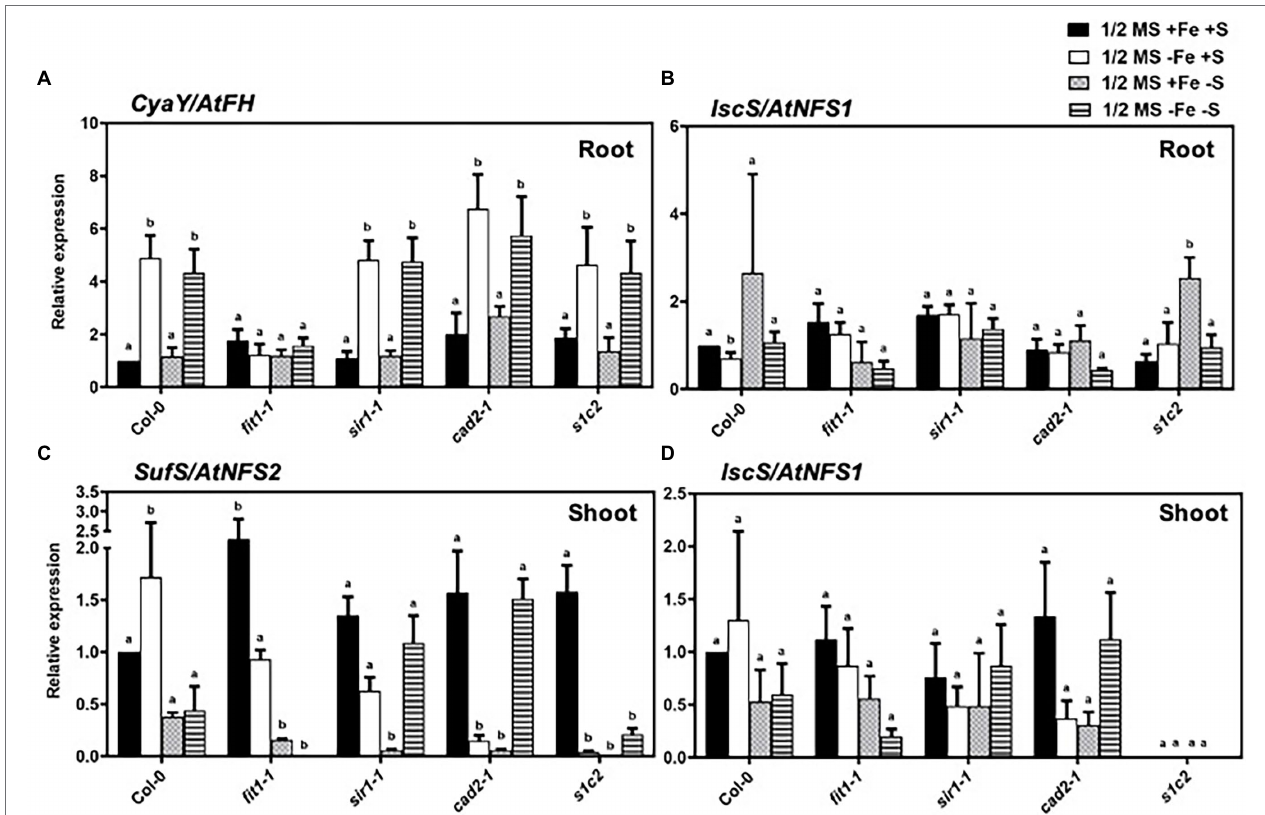
FIGURE 4 | Expression profiles of the genes related to Fe–S cluster biosynthesis in Arabidopsis . Relative expression by Quantitative RT-PCR of the genes: (A) CyaY/ frataxin in roots, (B) IscS/NFS1 in roots, (C) SufS/NFS2 in shoots and (D) IscS/NFS1 in shoots, for Arabidopsis the wild type (Col-0), fit1-2 , sir1-1 , cad2-1 , and s1c2 lines of 1-week old seedlings exposed onto half-strength MS medium (1/2 MS + Fe + S), Fe-deficient (1/2 MS − Fe + S), S-deficient (1/2 MS + Fe − S) and Fe and S-deficient (1/2 MS − Fe − S) media for 4 days under long-day conditions. The y -axis shows RNA levels normalized to that of GADPH . (A–D) Letters indicate the statistically significant differences between the wild type (Col-0) on ½ MS + Fe + S with the other treatments in Col-0 and mutants determined with the two-way ANOVA test followed by Dunnett’s test ( p < 0.05, n = 3). Bars represent means ±